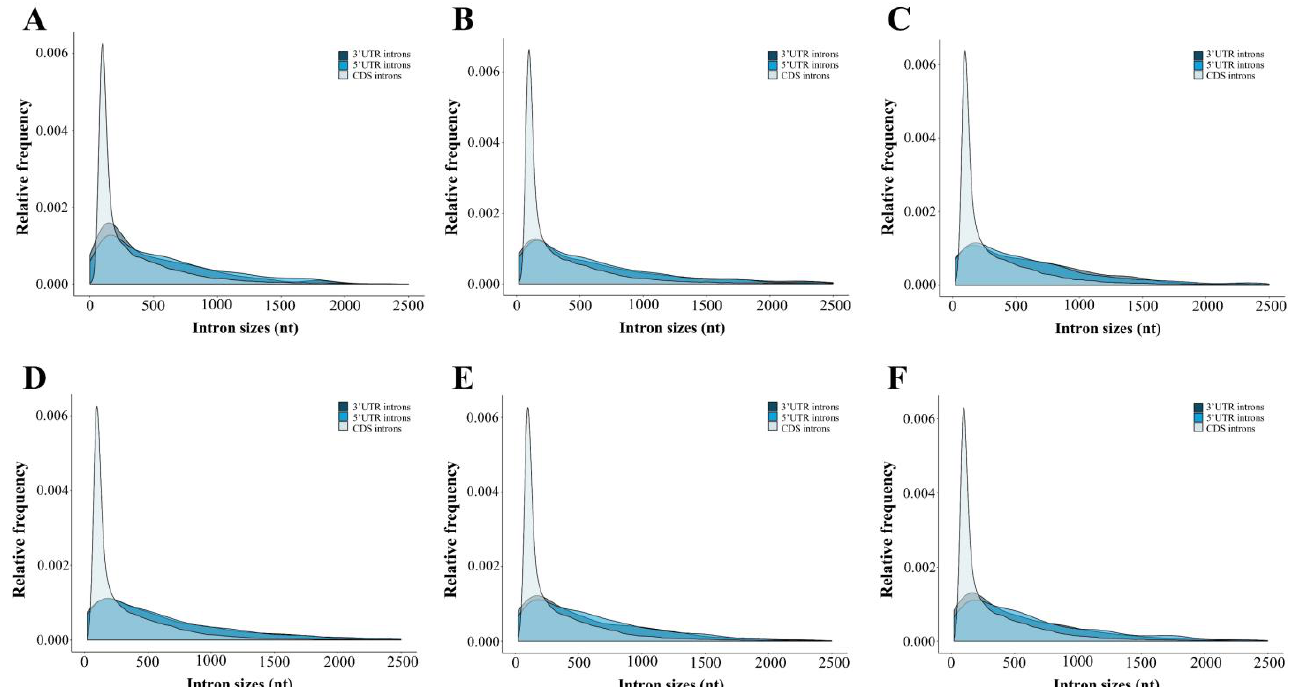
Figure 1. Length distributions of 5UI, 3UI and CIs in six citrus species. The CDS introns of all the six citrus species were found to be much more conserved in size than both the 5 (cid:48) UTR introns and 3 (cid:48) UTR introns, peaking in the range of 100~300 bp. ( A – F ) represents the intron length distribution result for C. sinensis [28], C. hindsii , C. maxima , C. reticulata , C. cavaleriei and C. medica , respectively. The